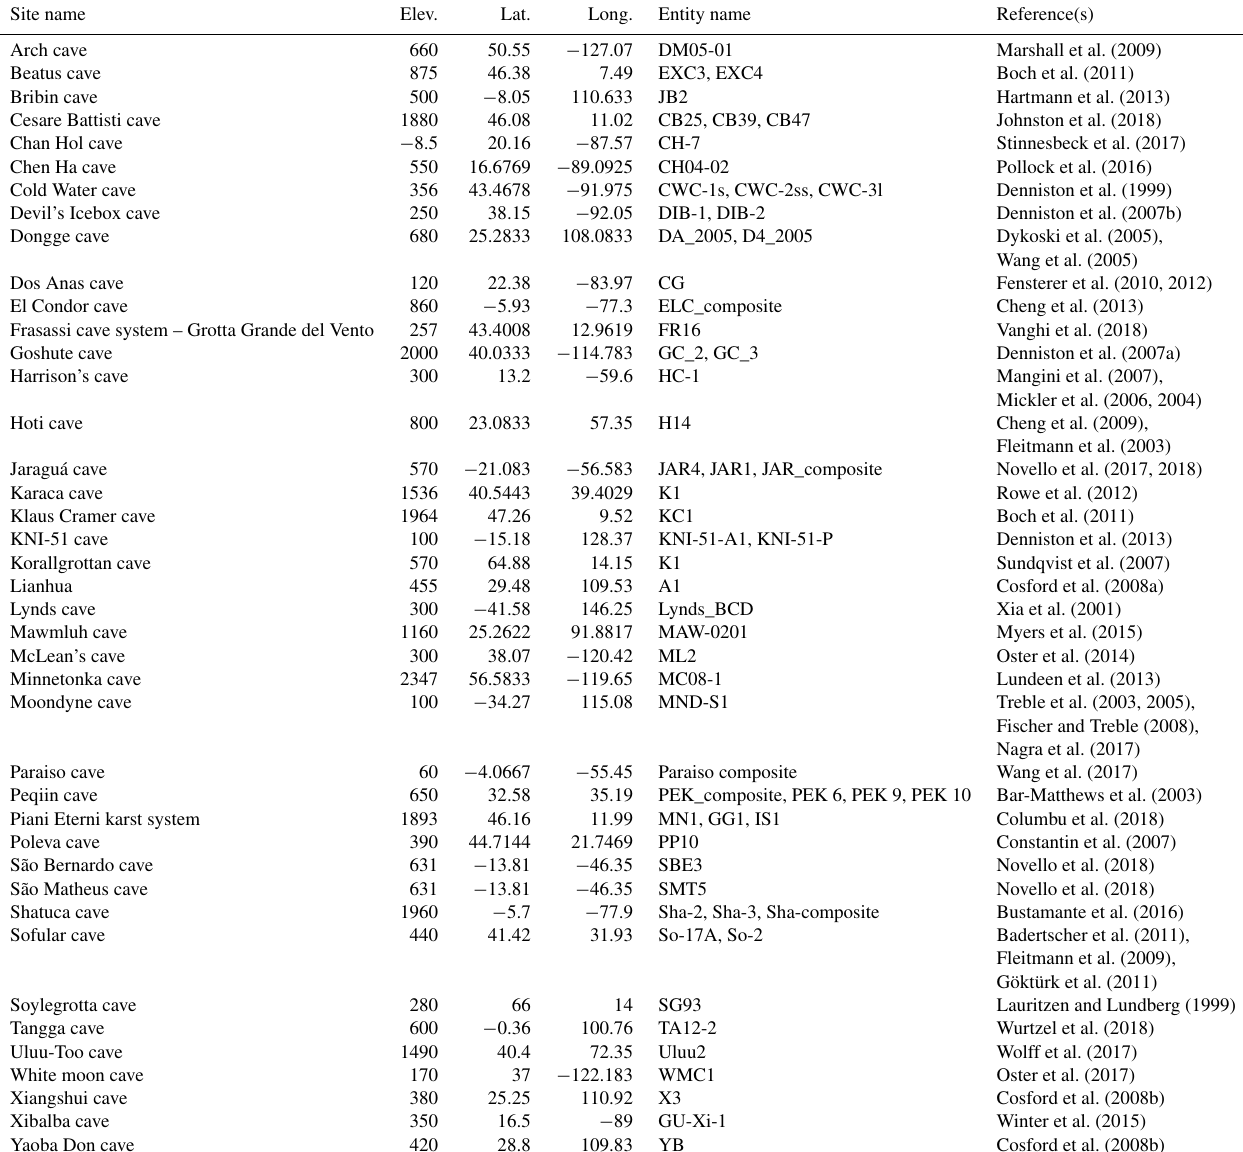
Table 1. List of speleothem records that have been added to SISALv1 (Atsawawaranunt et al., 2018a, b) to produce SISALv1b (Atsawawara- nunt et al., 2019) sorted alphabetically by site name. Elevation is in metres above sea level (ma.s.l.), latitude in degrees north and longitude in degrees